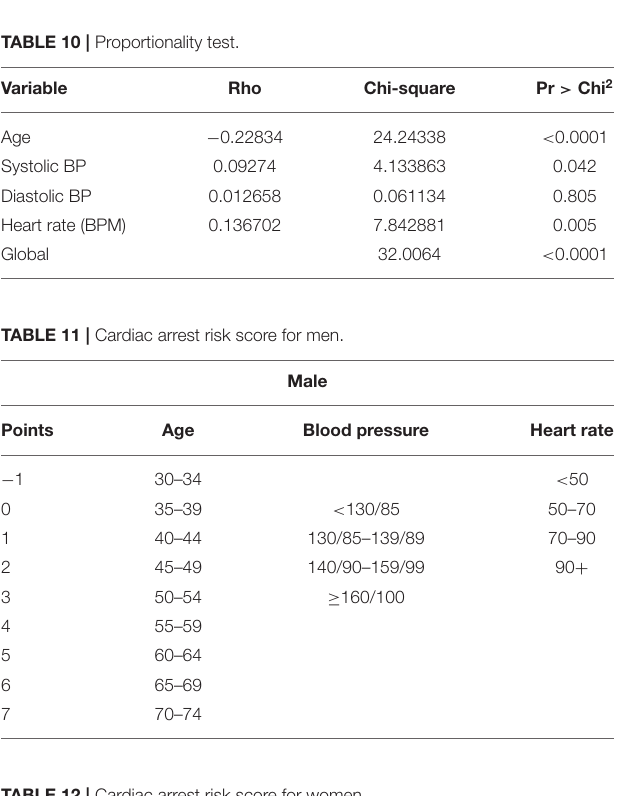
TABLE 12 | Cardiac arrest risk score for women.